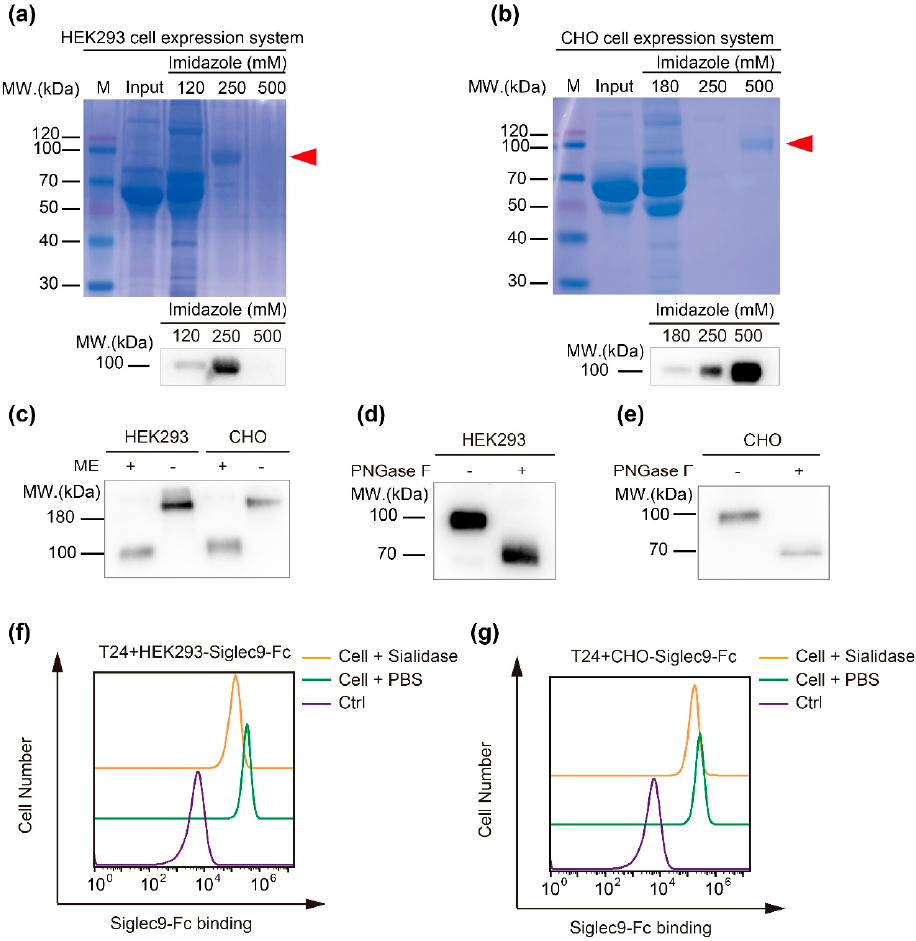
Figure 2. Siglec9-Fc protein purification, dimerization and sialic acid binding activity. Coomassie- stained SDS-PAGE gel and western blot of puri fi ed Siglec9-Fc produced in HEK293 ( a ) and CHO ( b ) cell lines, detected by anti-His antibody; ( c ) the western blot of monomer or dimer molecular weight of Siglec9-Fc produced in HEK293 and CHO cell lines, detected by anti-His antibody, ME: β - Mercaptoethanol; the western blot of Siglec9-Fc molecular weight change with PNGase F treatment in HEK293 ( d ) or CHO ( e ), detected by anti-His antibody, PNGase F: Peptide-N-Glycosidase F; the intensity of Siglec9-Fc produced in HEK293 ( f ) and CHO ( g ) binding on bladder cancer cell T24 membrane with or without sialidase treatment.